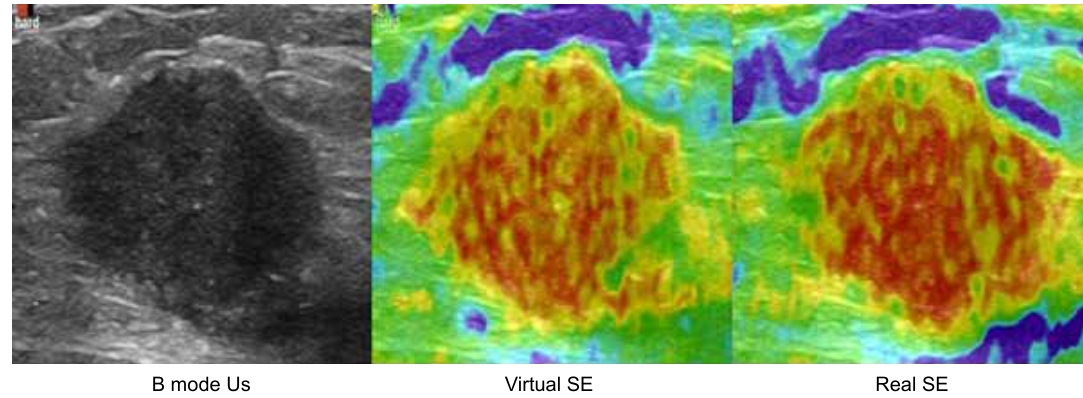
Figure 1 Example of virtual and real strain elastography ultrasound imaging. (Reprinted with permission from reference